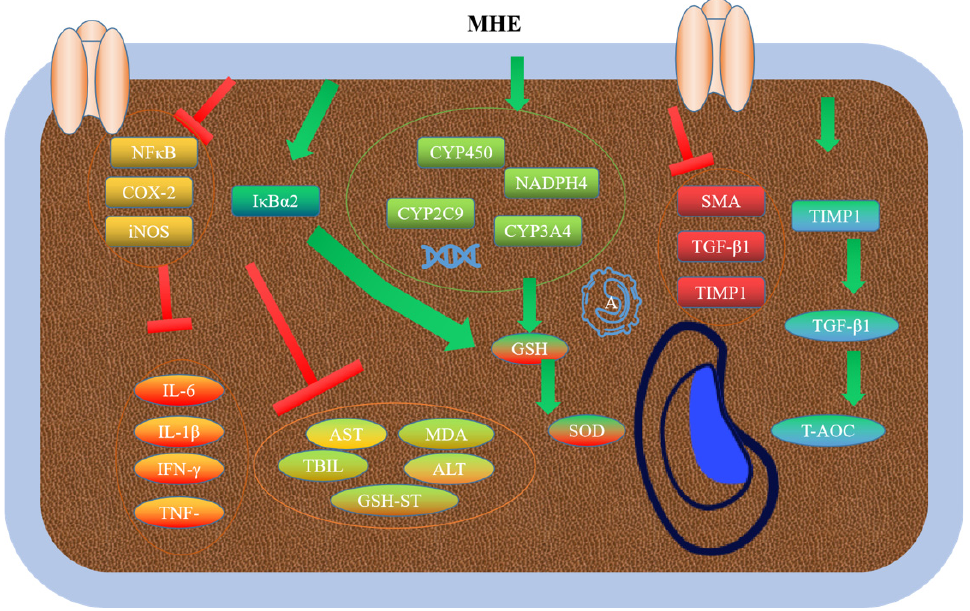
Figure 6. Hepatoprotective mechanism of